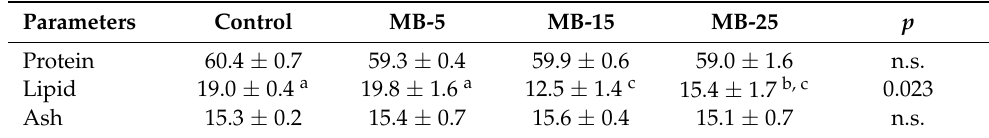
Table 4. Carcass composition (% in dry weight basis) of juvenile S. aurata specimens fed experimental diets for 30 days.